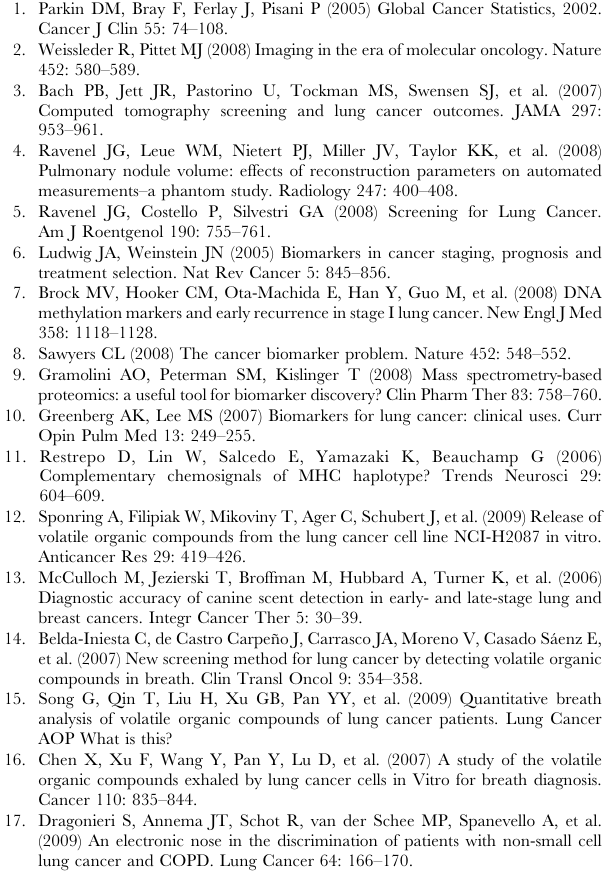
Figure S7 Regulatory factor determined by two-way ANOVA. Normalized intensity of subtracted peaks in a two-way ANOVA. Red: tumor, Blue: placebo, Circle: LKR, Star: